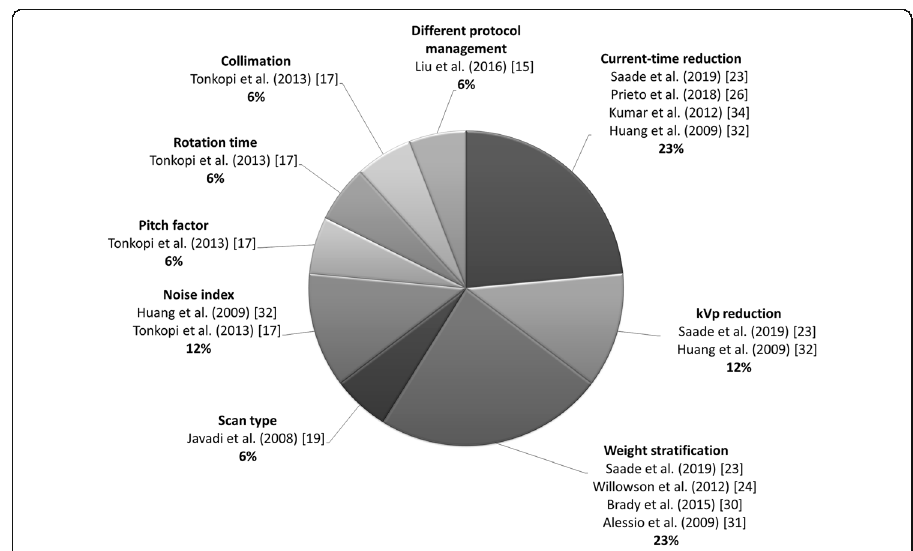
Fig. 3 Distribution of the CT optimisation strategies used in PET/CT